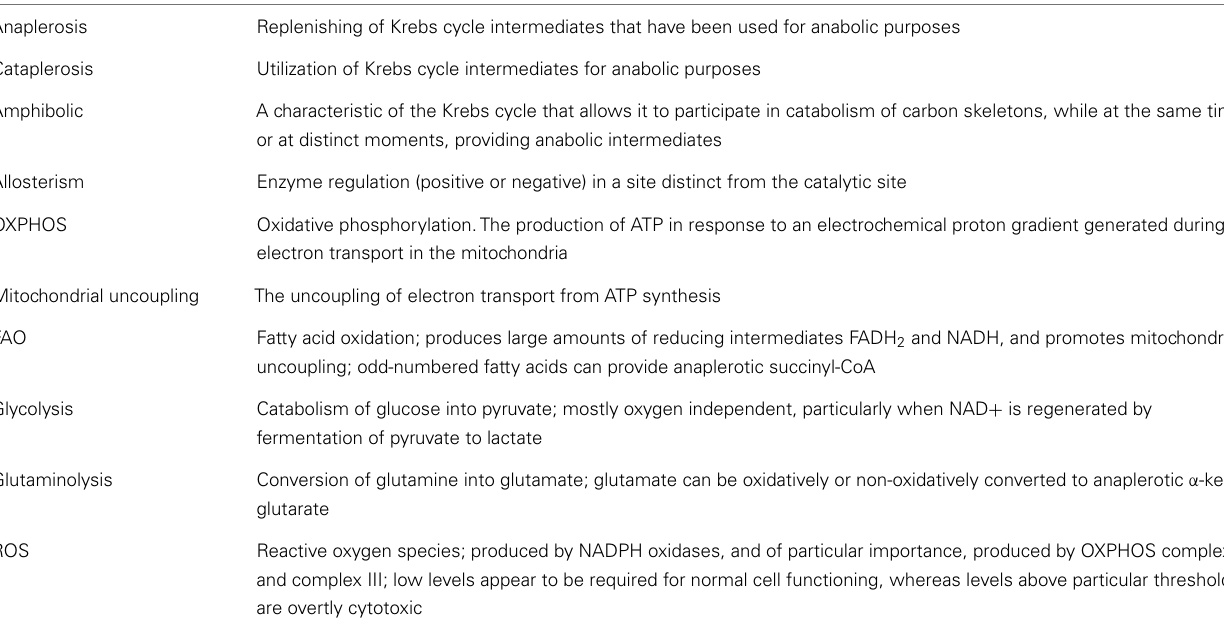
Table 1 | Glossary of